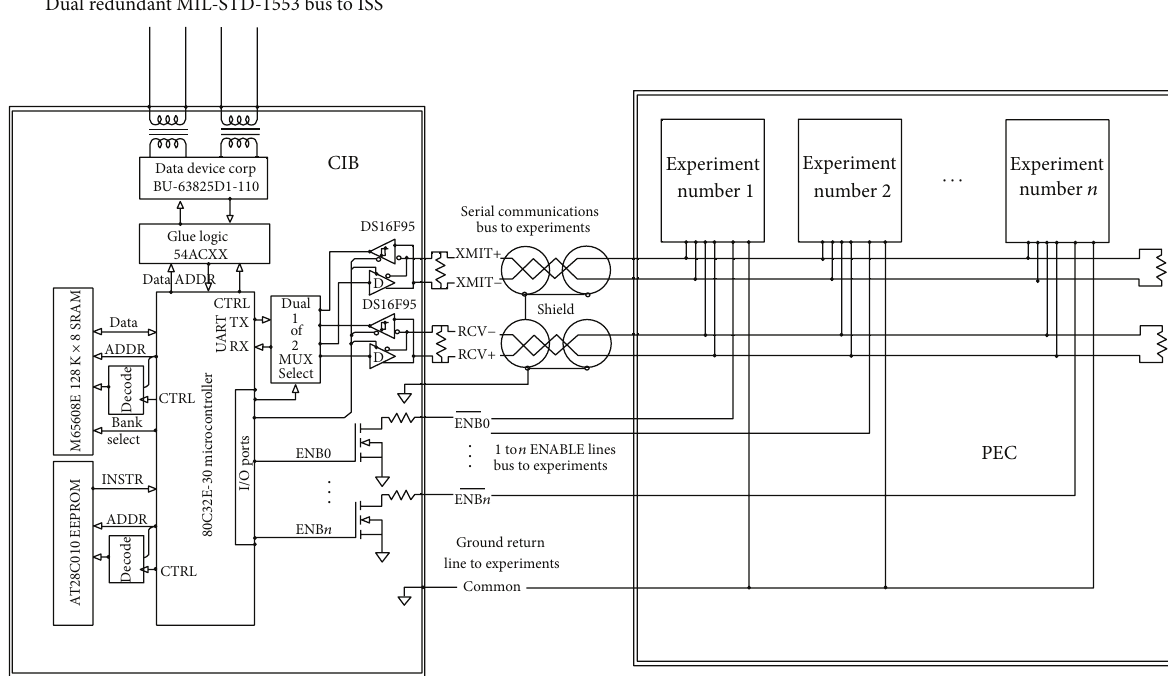
Figure 2: A block diagram of the Communications Interface Board (CIB) interfacing between the International Space Station (ISS) MIL- STD-1553 bus and the experiments residing on the Passive Experiment Container (PEC) (image courtesy of NASA). An example schematic for experiment n stub onto the PEC RS485 bus and to its ENABLE using the DS16F95